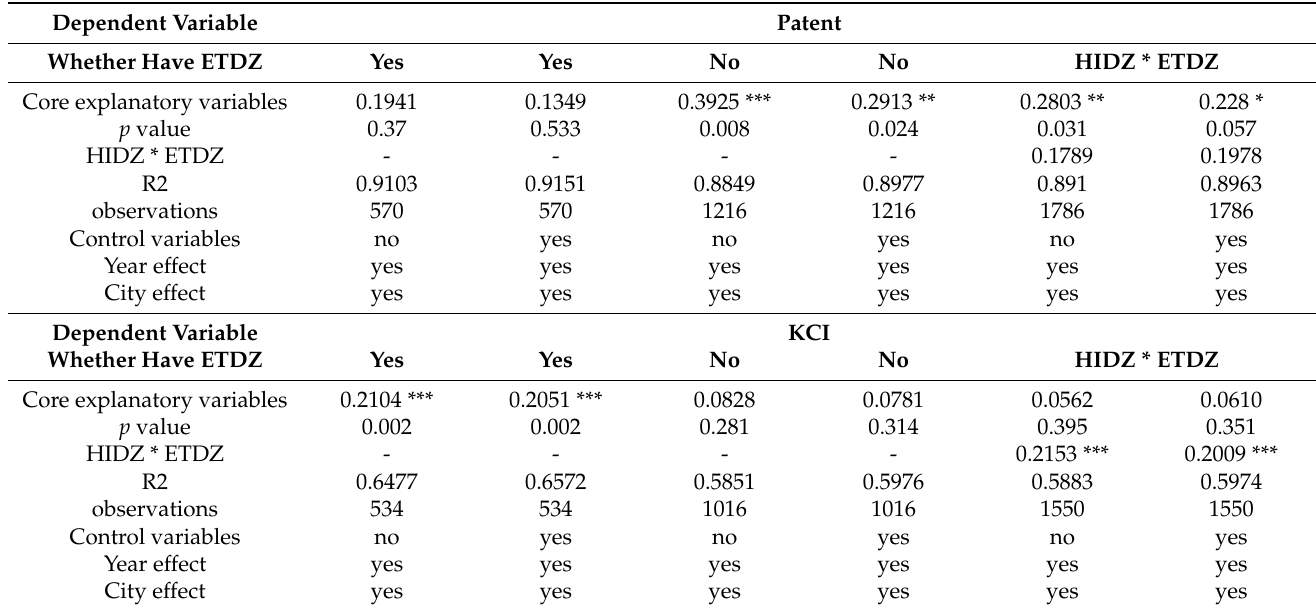
Table 7. HIDZ’s effects based on whether the host city had an ETDZ at the same